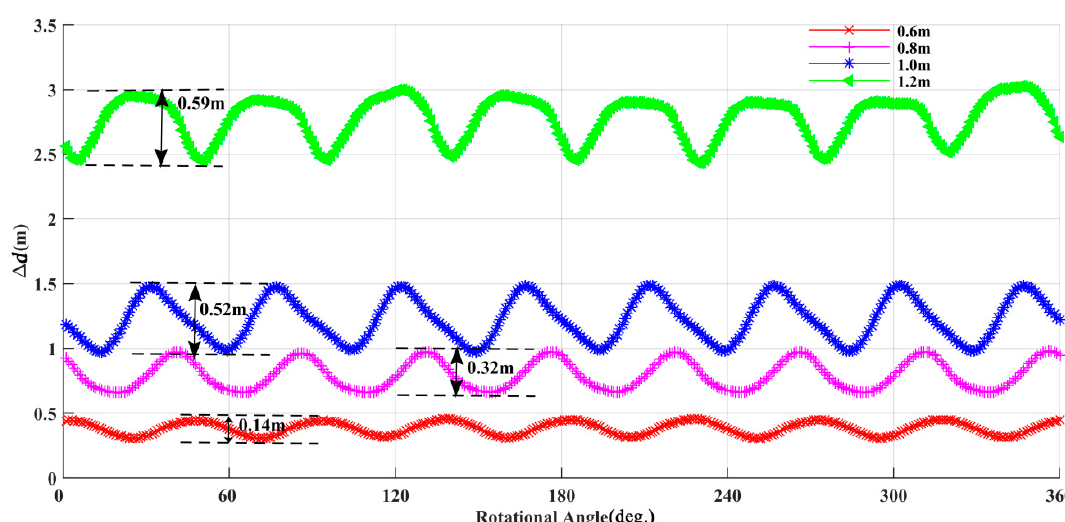
Figure 7. Torque variation in a cycle.